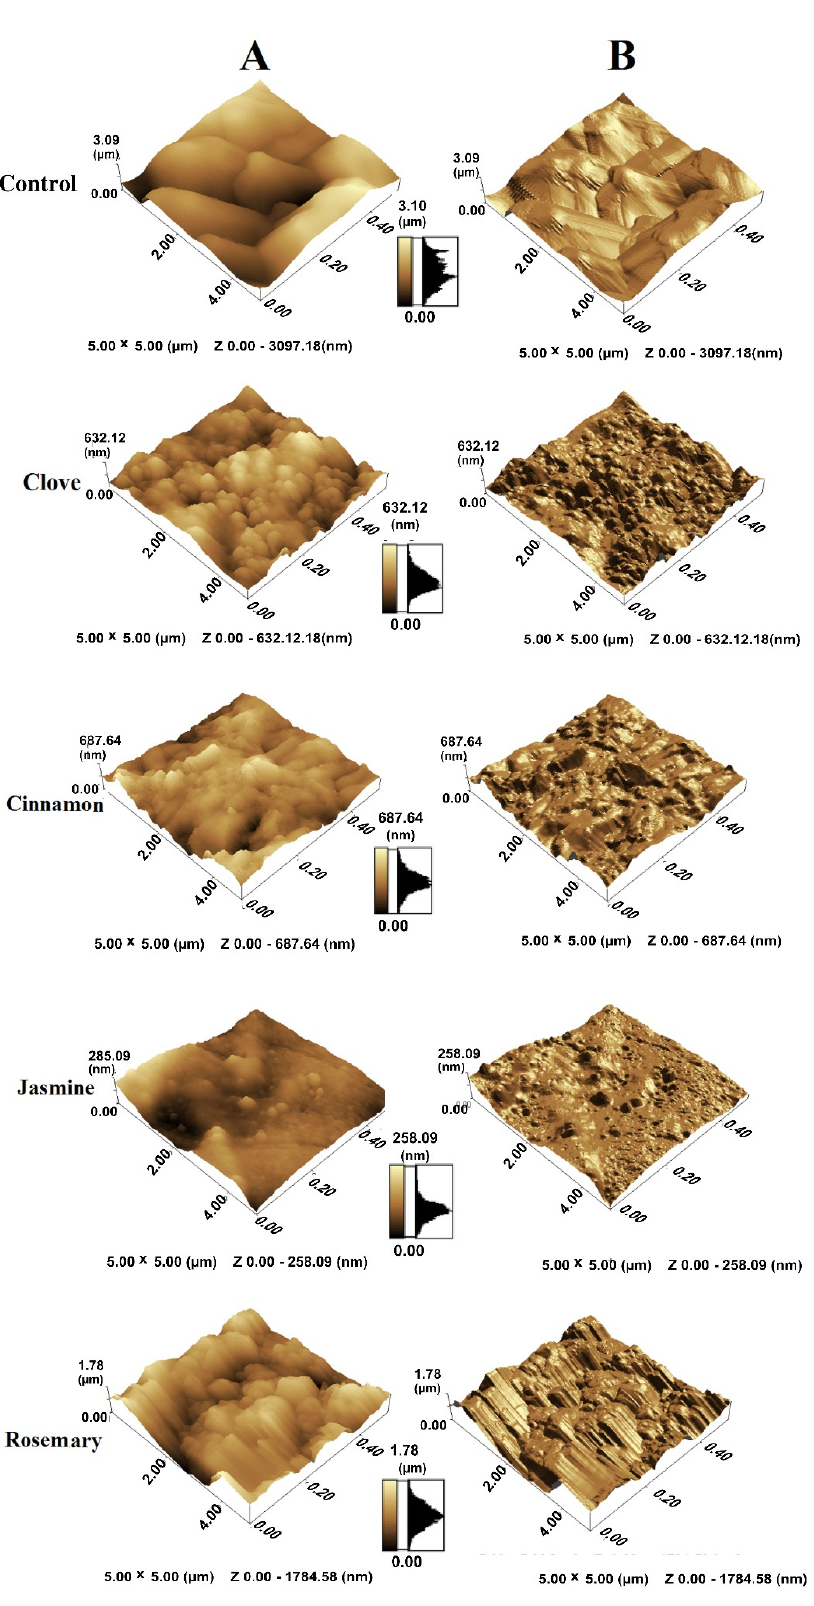
Figure 3. Atomic force microscopy 3D-topography images showing changes in cell height ( A ) and surface roughness ( B ) of Candida albicans control cells and EO-treated cells. Scanning area size is 5 × 5 µm.